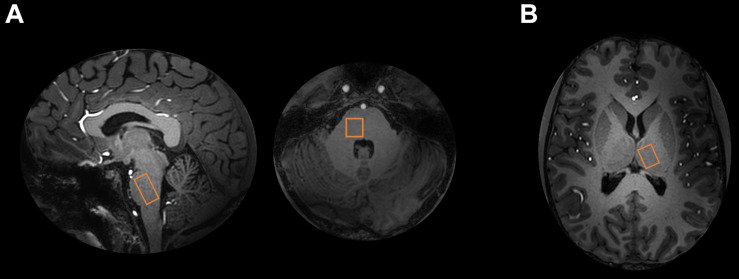
1H-MRS voxel locations. (A) Pontine and (B) thalamic 1H-MRS voxels are shown on 7T T1 image.